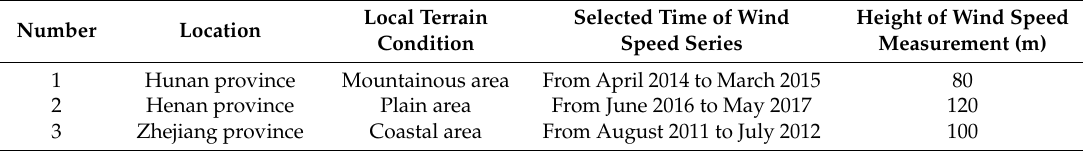
Table 1. Information of wind speed series from three anemometer towers.